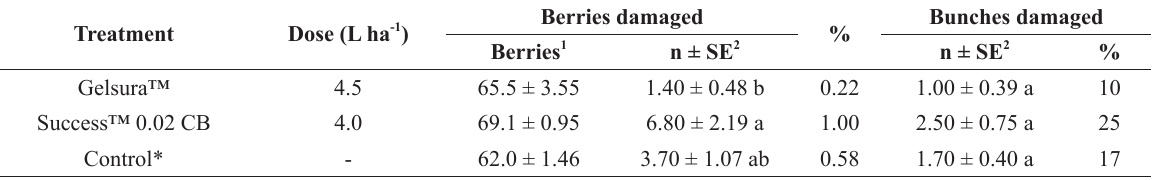
1 Average number ( n ) of berries evaluated in each bunch in each treated plot. 2 Number of berries/bunch and bunches with damage followed by the same letter in the column do not differ (Tukey’s test at 5% probability of error). *Control plot with the application of